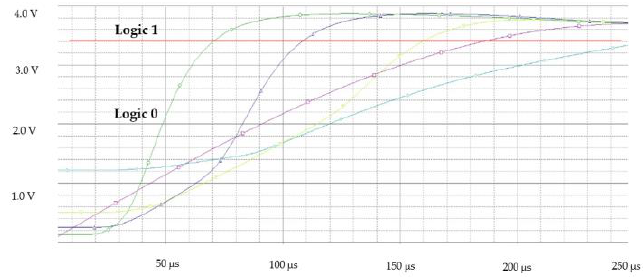
Figure 11. Demodulation Circuit.